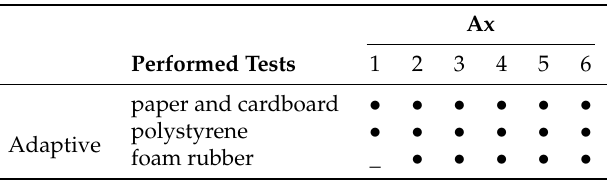
Table 4. Axes able to detect the collision for the three different materials using the adaptive virtual